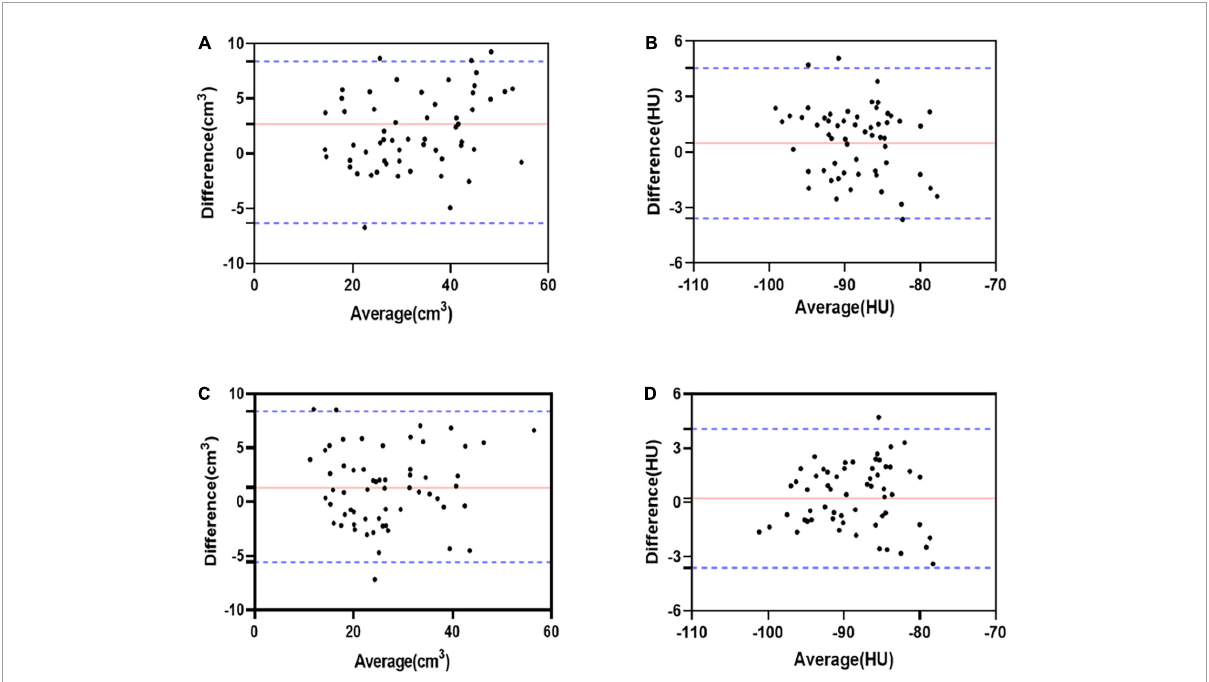
FIGURE4 Bland-Altman bias and limits of agreement for LA-EAT volume and attenuation between interobserver. LA-EAT volume, with a bias of 2.68 ± 4.61 cm 3 and the 95% limits of agreement was –6.34–11.7 cm 3 (A) ; LA-EAT attenuation, with a bias of 0.47 ± 2.07 HU and the 95% limits of agreement was –3.59–4.55 HU (B) . Bland-Altman bias and limits of agreement for LA-EAT volume and attenuation between intraobserver. LA-EAT volume, with a bias of 1.32 ± 3.51 cm 3 and the 95% limits of agreement was –5.57–8.21 cm 3 (C) ; LA-EAT attenuation, with a bias of 0.23 ± 1.96 HU and the 95% limits of agreement was –3.61–4.07 HU (D) .